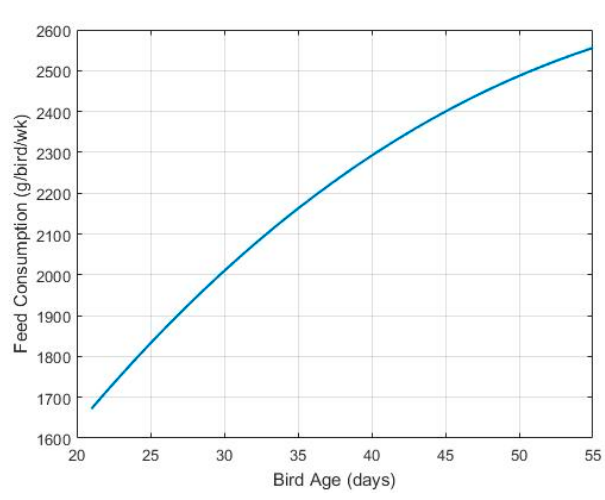
Figure 3. Feed consumption curve.